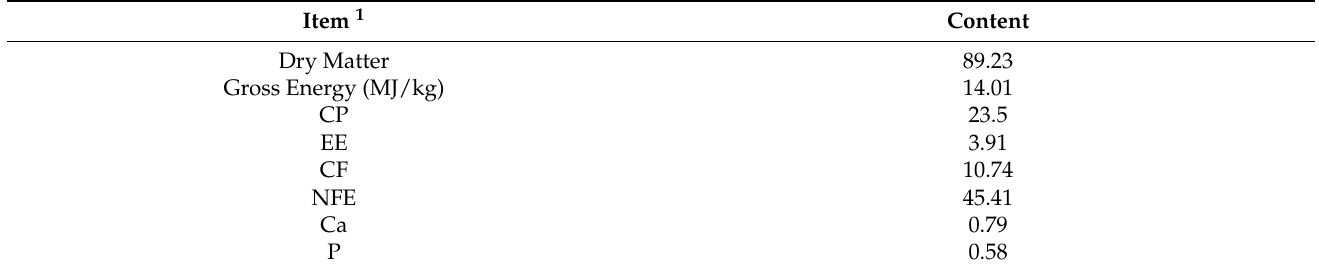
Table 1. The nutritional content of tea powder (%).